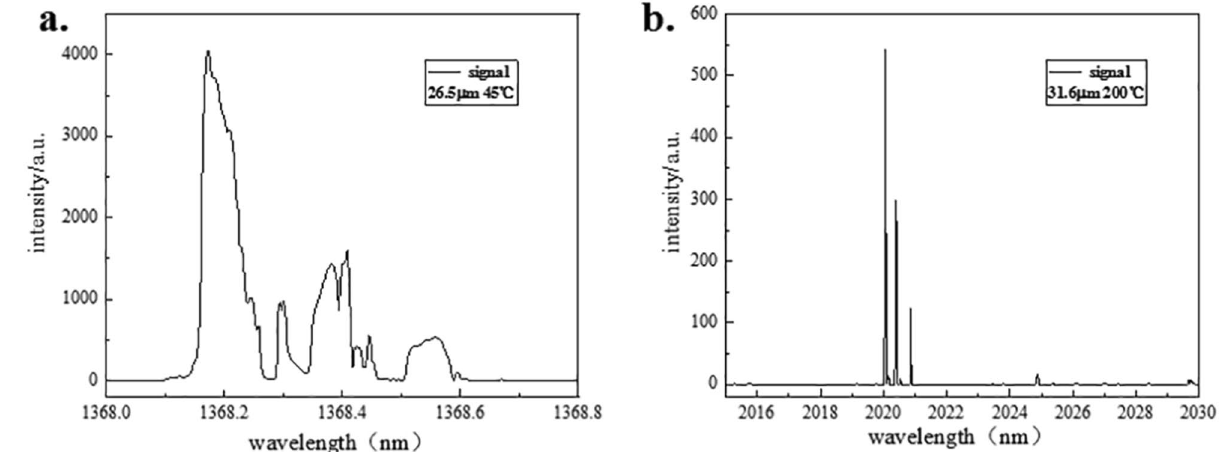
Figure 5. Shortest and longest signal spectra. ( a ) Shows the spectrum of shortest signal; ( b ) shows the spectrum of longest signal. (Origin 2018, https ://www.origi nlab.com/, Adobe Photoshop CC 2018, https ://www.adobe .com/cn/produ cts/photo